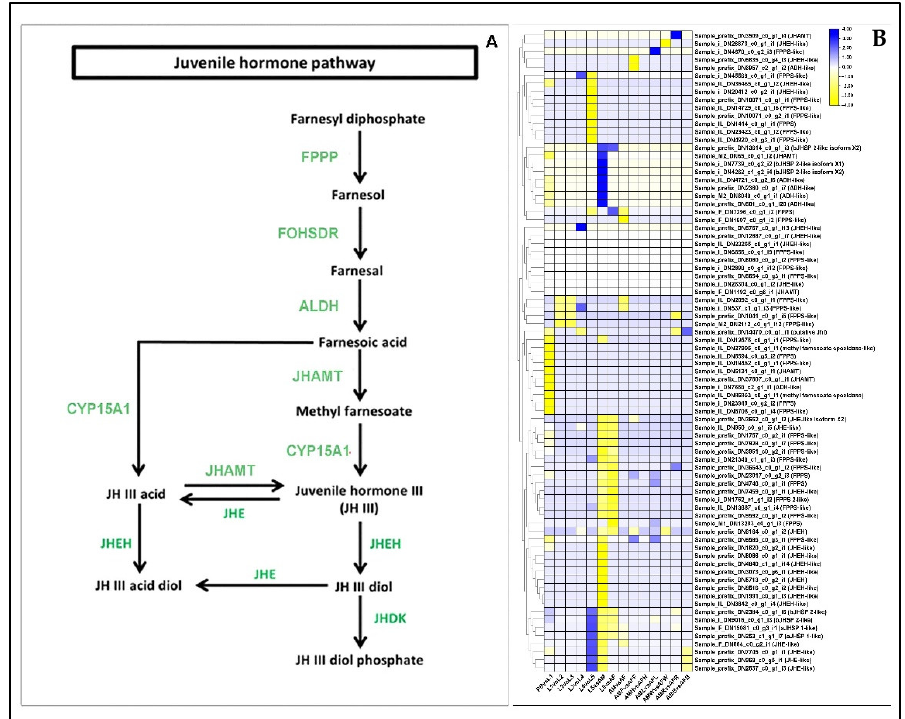
Figure 5. Identification of genes assigned to the Juvenile Hormone biosynthetic (JHB) pathway in the P. bremeri transcriptome. KAAS was used to identify genes annotated by BLAST against the specific insect database and assigned to a KEGG pathway ( A ) JH biosynthetic pathway components/gene. Colored boxes indicate the presence of the genes identified. A green colored box signifies the presence of an annotated gene that does not show a change in expression levels. ( B ) Heat map showing the log2-fold change of the FPKM values of the DEGs.